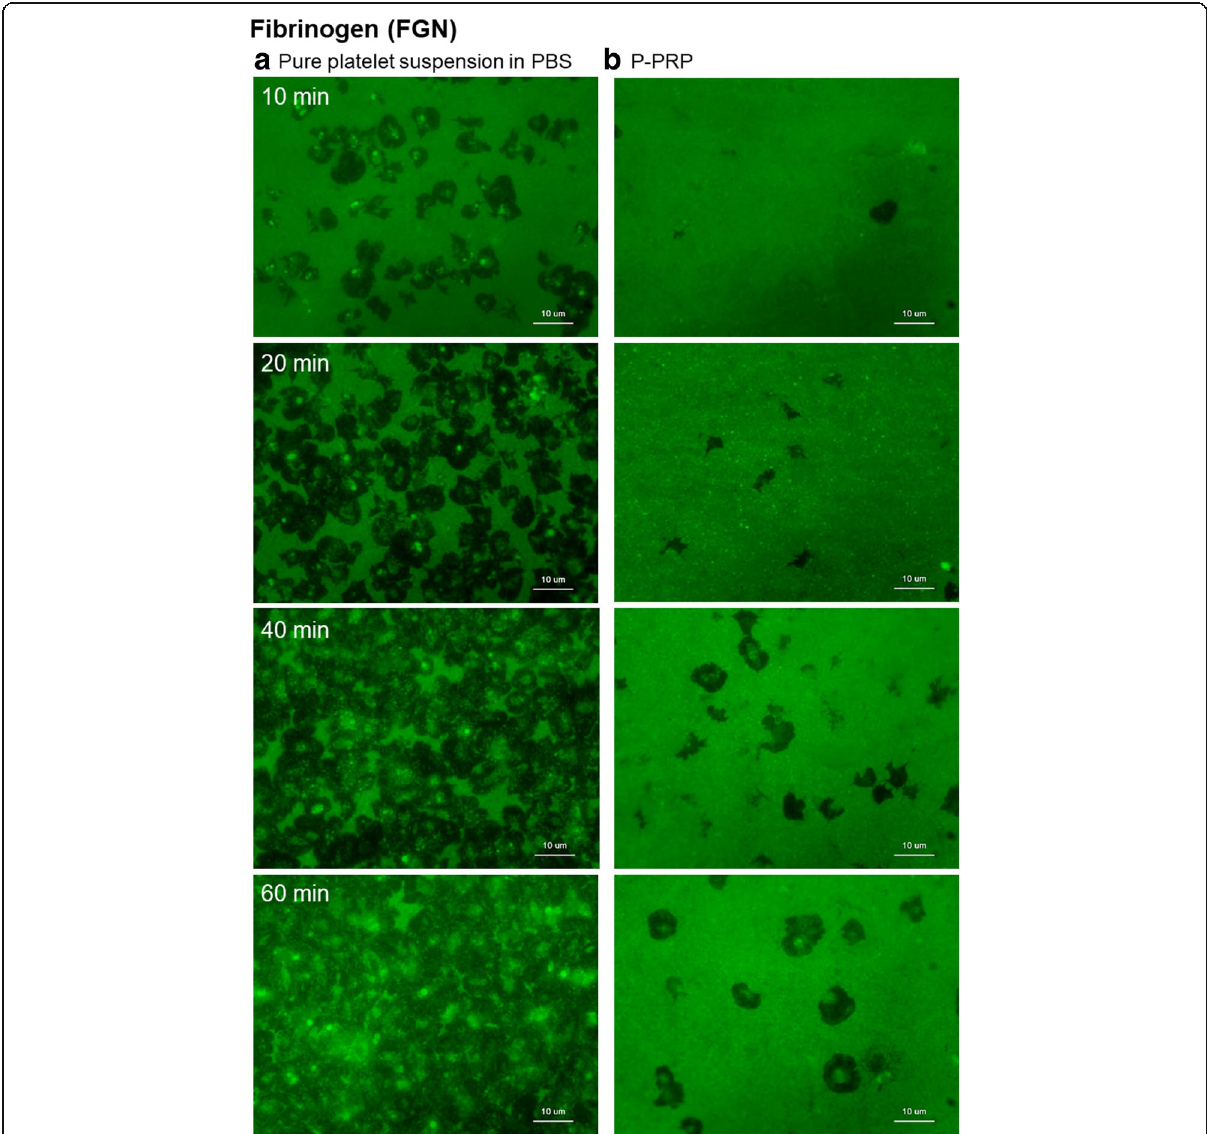
Fig. 4 Distribution of FGN (green dye) on the surface of cp -Ti plates. a Platelets suspended in PBS and b P-PRP. FGN fibrinogen, cp - Ti commercially pure titanium, PBS phosphate-buffered saline, P - PRP pure platelet-rich